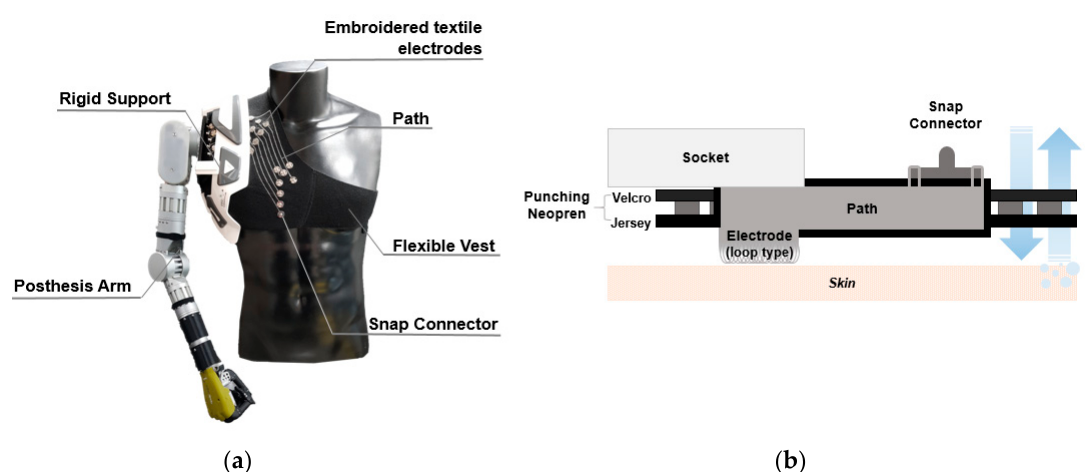
Figure 3. Wearable vest socket with embroidered textile electrodes. ( a ) Prototype of wearable vest socket and prosthetic arm; ( b ) cross-sectional view of wearable vest socket with the embroidered textile electrode.